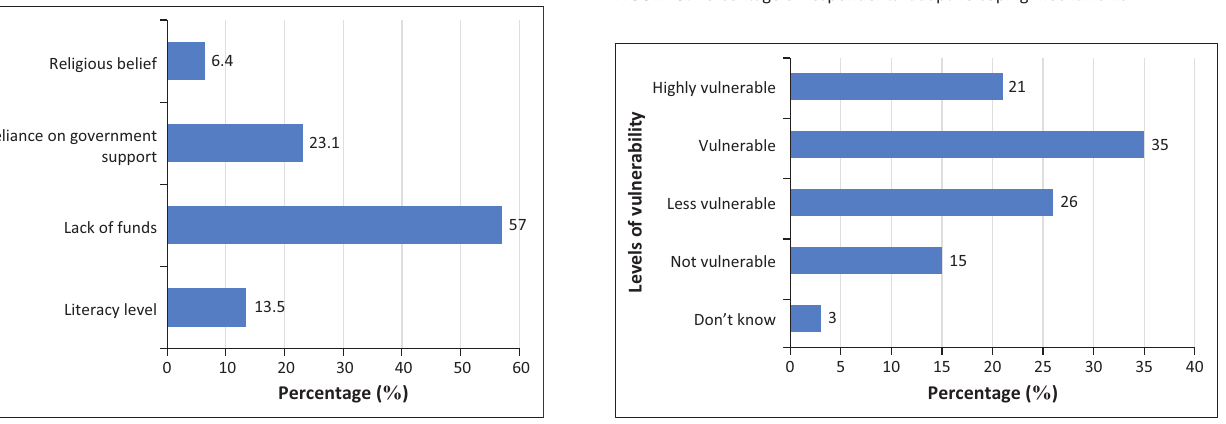
FIGURE 10: Percentage of respondents’ rank of vulnerability to risks attributed to